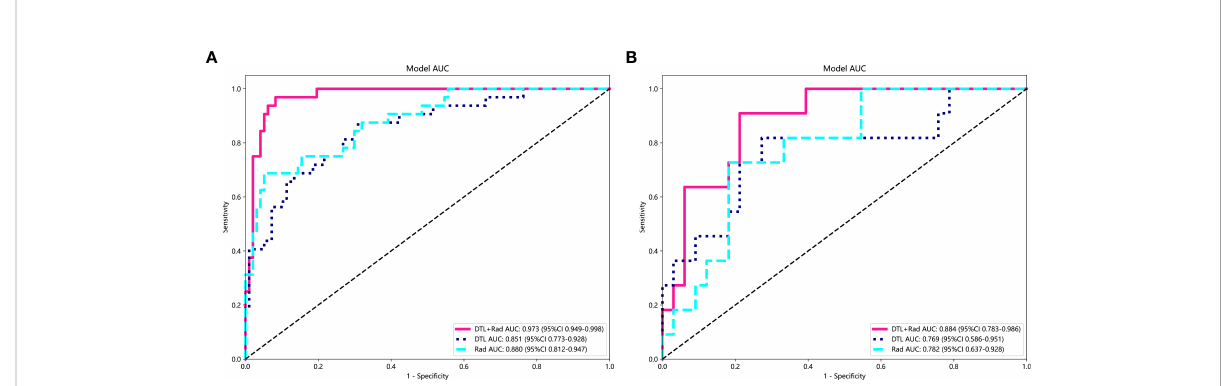
FIGURE 6 In the above fi gure, the performance of the MLP model is shown under the radiomics-only approach, the deep transfer learning approach, and the deep learning radiomics-based signature approach. Rad, Radiomics; DTL, Deep Transfer Learning; DLR, Deep Learning Radiomics. (A) Model performance in the training set. (B) Model performance in the test